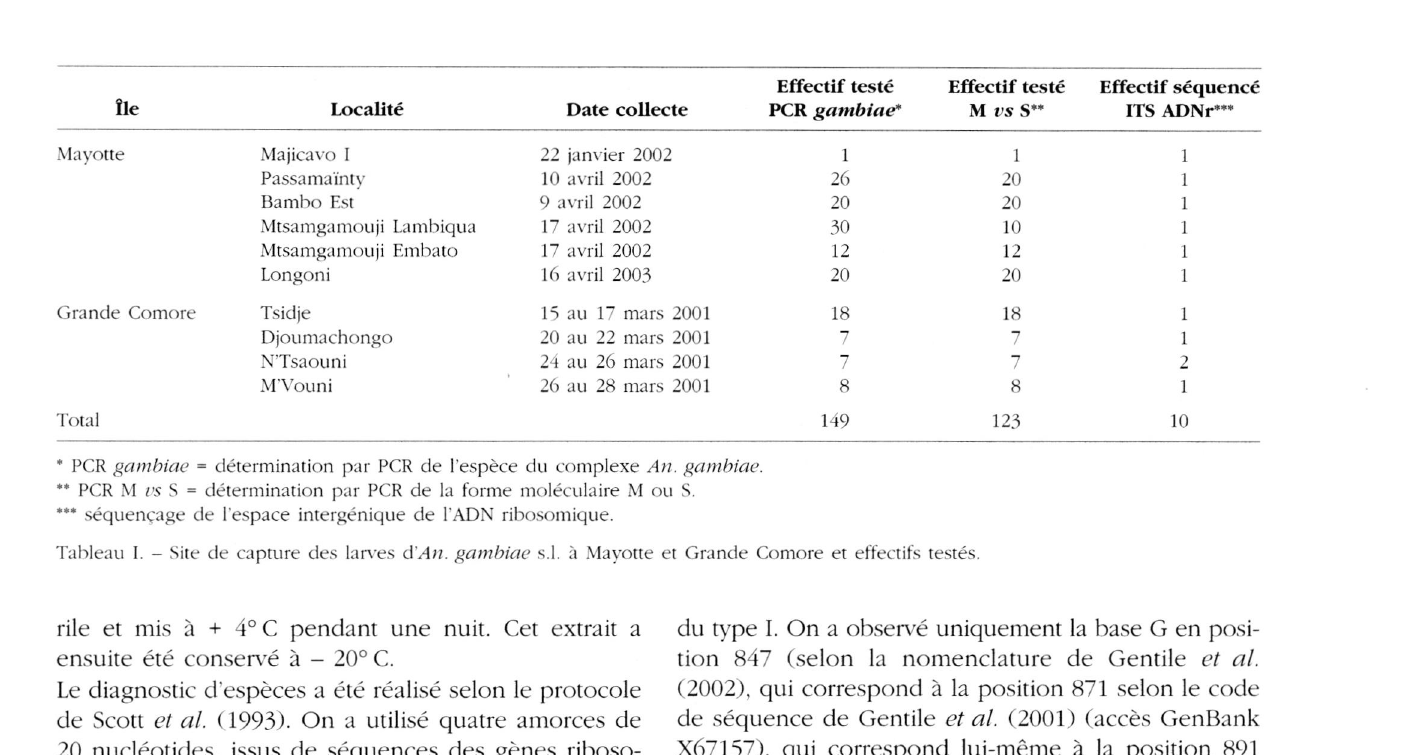
Tableau I. - Site de capture des lanes d 'An., gambiae s.l. à Mayotte et Grande Comore et effectifs